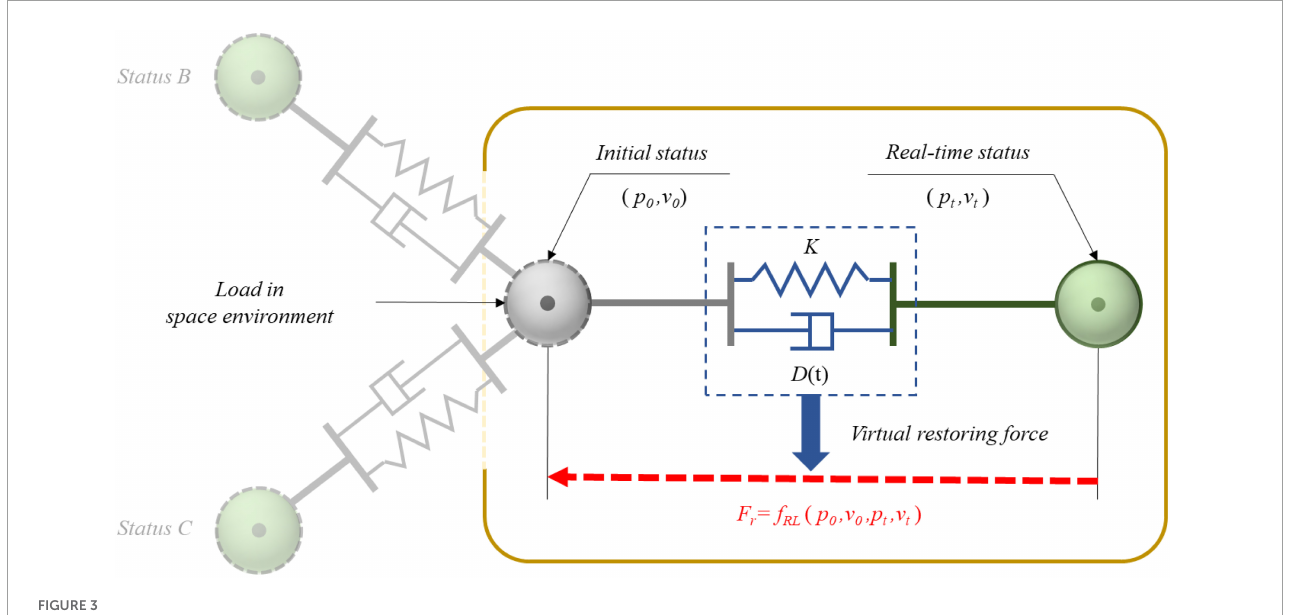
FIGURE3 Variable damping control principle for load in weightless